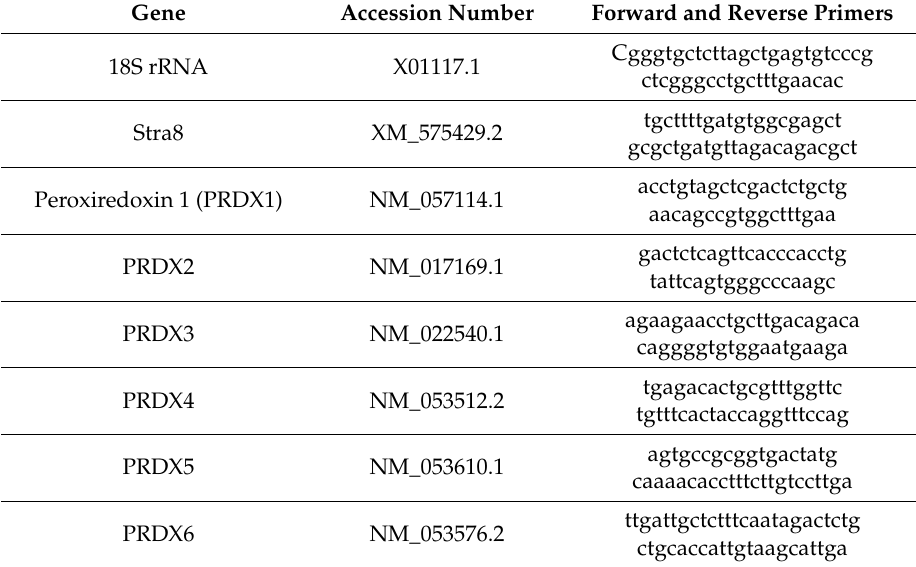
Table 1. Primer sets for qPCR analysis of genes in rat gonocytes. The underlined bases correspond to bases added to the gene sequence by the primer design program to generate better-balanced